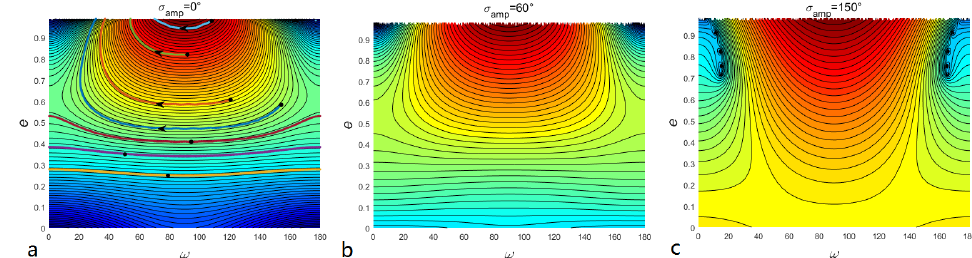
Figure 5. Phase-space portraits of Kozai–Lidov dynamics inside the polar 2/1 resonance. The levels of Hamiltonian in Equation (5) or (6) are plotted on an e − ω plane. The panels ( a – c ) represent three different cases ( σ amp = 0 ◦ ,60 ◦ ,150 ◦ ). The thick colored solid lines in panel a represent the several representative results of numerical integrations. The solid black dots mark the positions of initial parameters and the arrows indicate the evolution direction of the dying